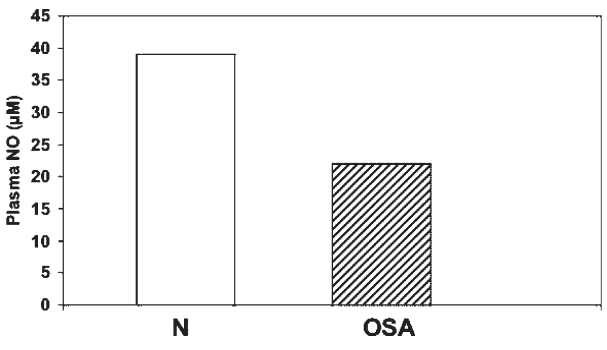
Figure 3 - Reduction in nitric oxide (NO) production in persons with obstructive sleep apnea (OSA) as compared to normal (N) controls (adapted from ref.